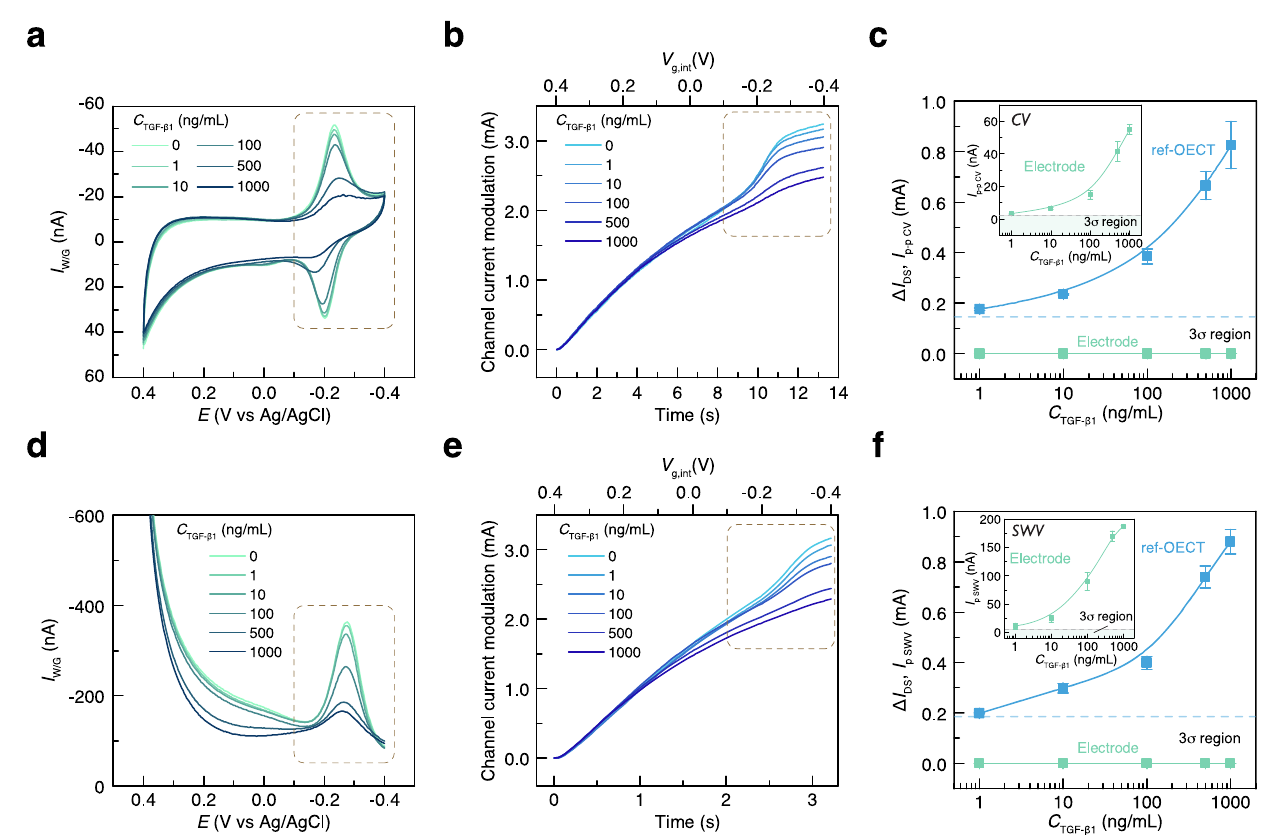
Fig. 4 | TGF- β 1 sensing. a, d Series of CV and SWV results of the E-AB sensor with different concentration of TGF- β 1 . Decreased redox peak is induced by increasing the concentrationofTGF- β 1 . b, e Seriesof channelcurrent modulation inref-OECT withdifferentconcentrationofTGF- β 1 whenperformingtheCV/SWVmeasurement inE-ABsensor.Decreasedchannelcurrentmodulationisinducedbyincreasingthe concentration of TGF- β 1. c, f Calibration curves of TGF- β 1 sensing based on bare E-AB sensors and ref-OECT-based E-AB sensors (error bars represent standard deviation, N =3). Ref-OECT-based E-AB sensor shows ~12000-fold enhancement